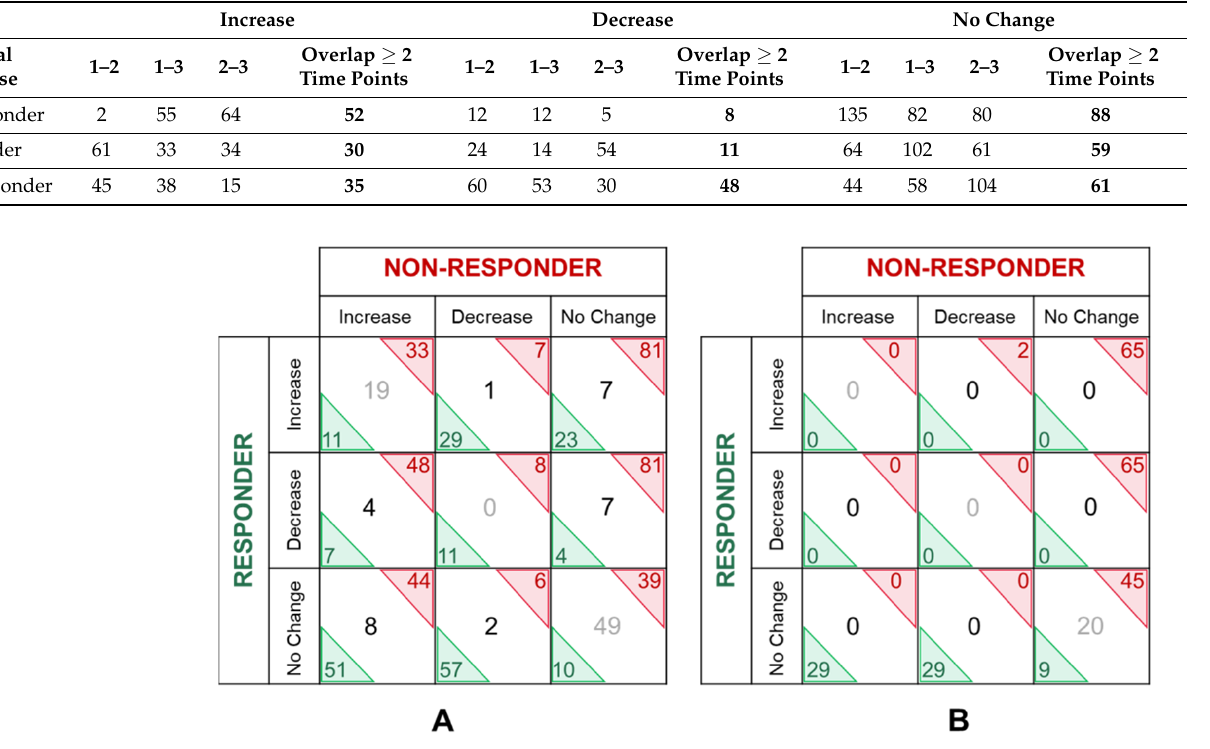
Figure 4. Numerical comparison of extracellular vesicle associated protein abundance changes. Proteins whose abundance was increased or decreased in at least two of the three plasma samples assayed (Tables 2 and 6) were compared between the responder and the non-responder. Proteins were considered as candidate EV associated proteins ( A ) or classical, high abundant plasma EV associated proteins ( B ). Table 3. Extracellular vesical associated proteins that are increased in abundance in the